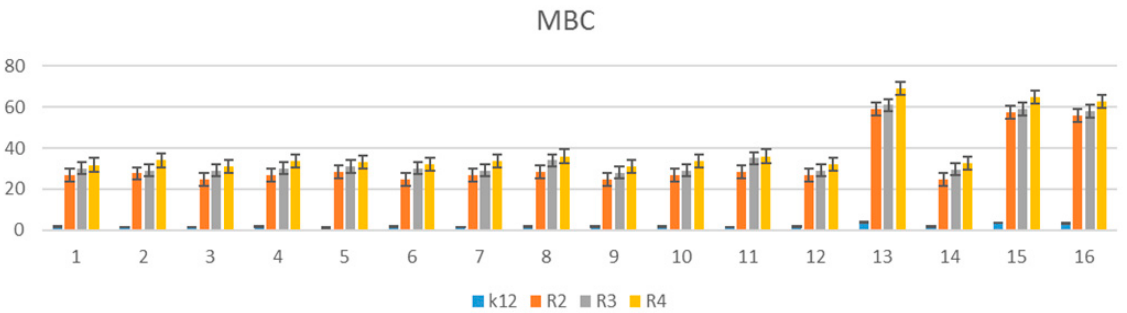
Figure 4. Minimum bactericidal concentration (MBC) of the phosphonate derivatives. The x -axis features compounds 1 – 16 used sequentially. The y -axis shows the MIC value in µg/mL − 1 . Investigated strains of E. coli K12 as control (blue), R2 strains (orange), R3 strains (grey), and R4 strains (yellow). The order in which the compounds were applied to the plate is shown in Supplementary Materials Figure S1.